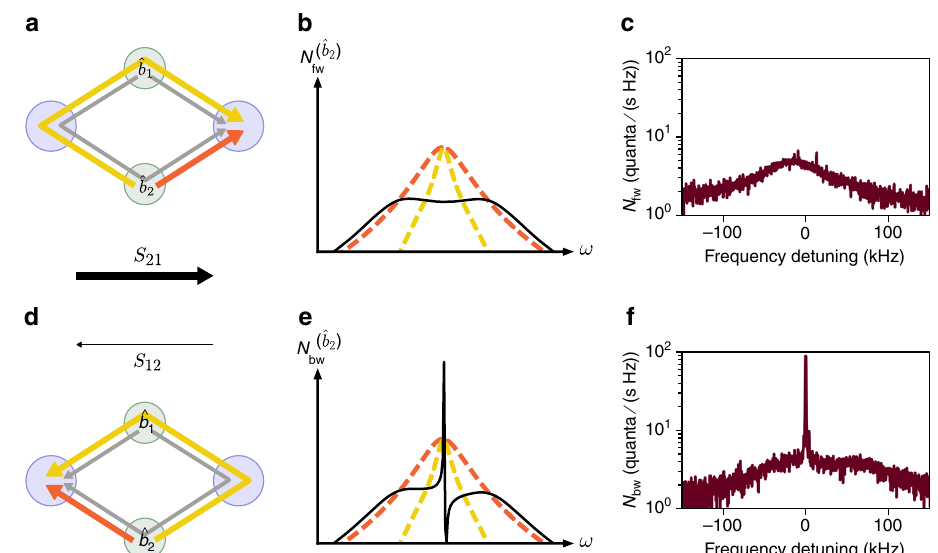
Fig. 4 Asymmetric noise emission of the nonreciprocal circuit. The noise emission is mainly due to mechanical thermal noise, that is converted through two paths to the microwave modes. The resulting interference creates a different noise pattern in the forward a – c and the backward d – f directions when the circuit is tuned as an isolator from mode ^ a 1 to ^ a 2 . a , d The two possible paths for the noise are shown for each mechanical mode. For ^ b 2 , the direct path ( orange ) and the indirect path going through mode ^ b 1 ( yellow ) are highlighted (the corresponding paths for ^ b 1 are shown in grey ). b , e Each path on its own would result in a wide noise spectrum that is equally divided between the two microwave cavities ( dashed yellow and orange lines ). When both paths are available, however, the noise interferes differently in each direction ( solid lines ). In the backward direction e , a sharp interference peak appears, of much larger amplitude than the broad base. The theoretical curves (on an arbitrary logarithmic scale) are shown for the symmetric case ( Γ m,1 = Γ m,2 ) and for the single mode ^ b 2 . Note that for the mode ^ b 1 , the shape of the asymmetric peak in the backward noise would be the mirror image. c , f Measured output spectra of modes ^ a 2 ( c ) and ^ a 1 ( f ), calibrated to show the photon fl ux leaving the circuit. Because cross-damping provides extra cooling for the mode ^ b 1 , the thermal noise of ^ b 2 is expected to